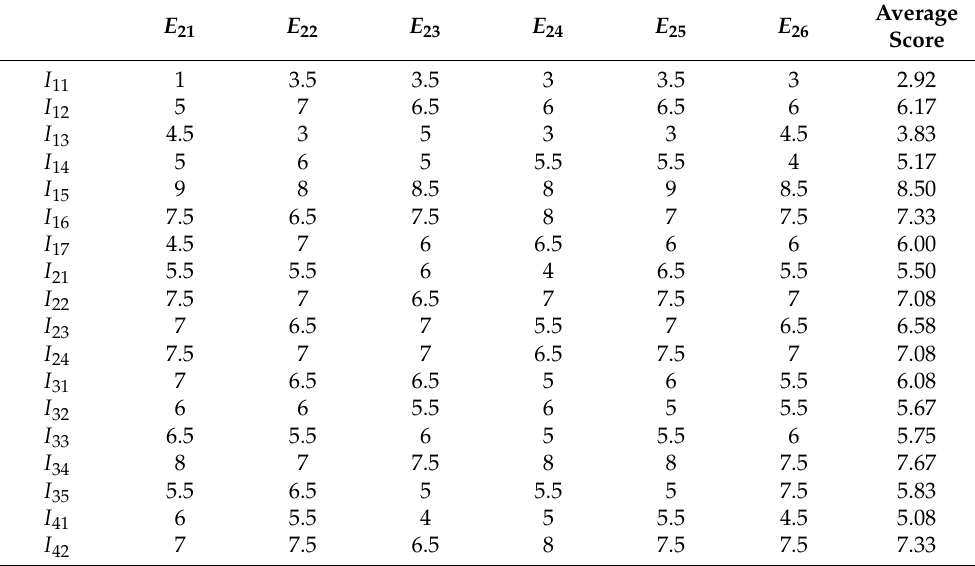
Table 7. The initial performance scores of the IM performance indicators.